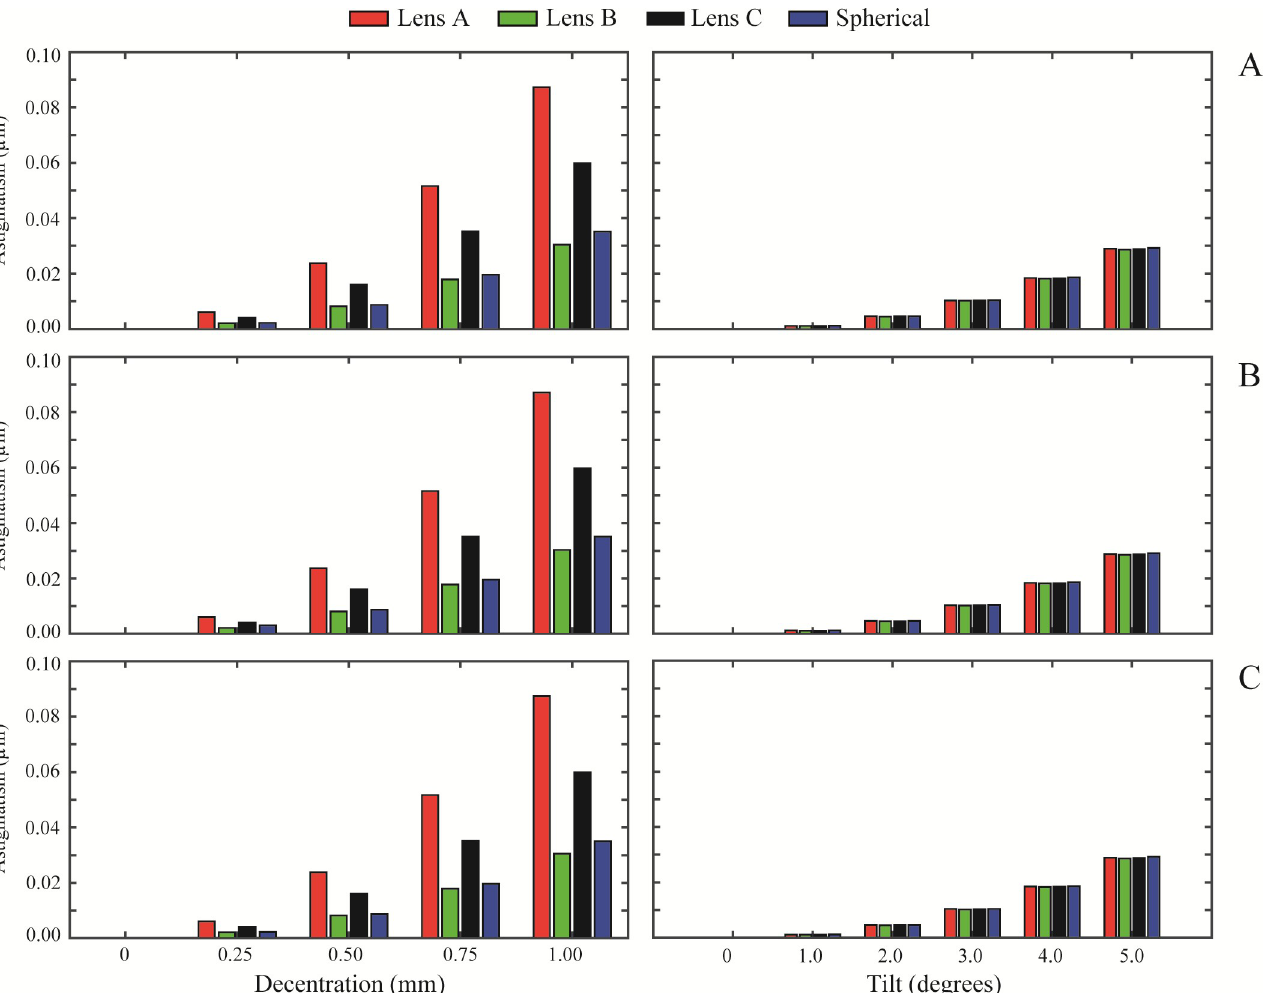
Fig 3. RMS astigmatism ( Z (cid:0) 2 and Z 2 ) values of the designed IOLs for misalignment (left column) and tilt (right column) with each different cornea: A) Normal, 2 2 B) Myopic, C)